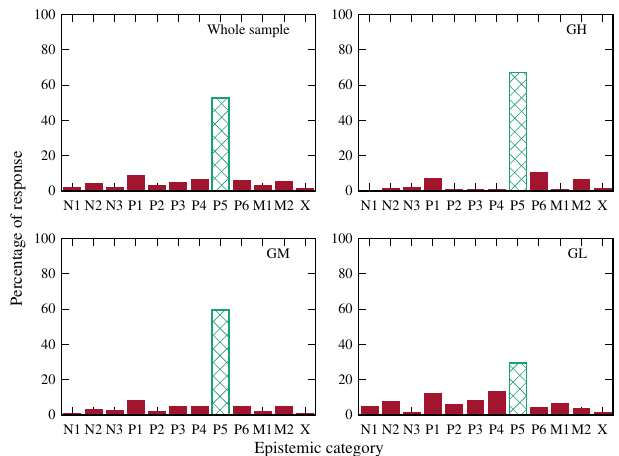
FIG. 10. Aggregate distribution of responses to all propositions (S14, S24, and S32) corresponding to epistemic category P5. Format of the figure is the same as in Fig.